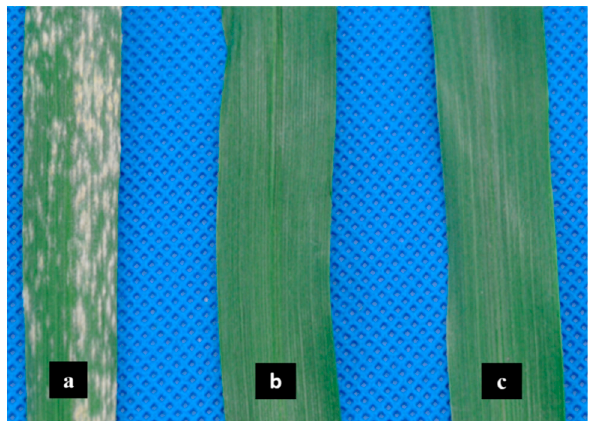
Figure 1. Different responses of wheat leaves to Blumeria graminis f. sp. tritici (Bgt) infection after six days. ( a ) Susceptible wheat cultivar Chuannong26 . ( b ) Resistant wheat cultivar L699 . ( c ) Resistant wheat cultivar Neimai836 .